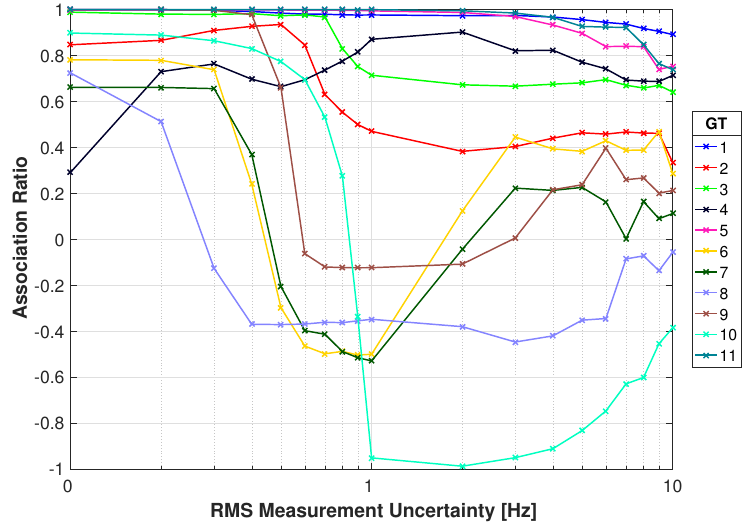
Figure 19. Confidence ratio for matching specific cellular emanation measured by the constellation of RF receivers with the corresponding target from the multi-spectral video tracker using the RMSD DD.